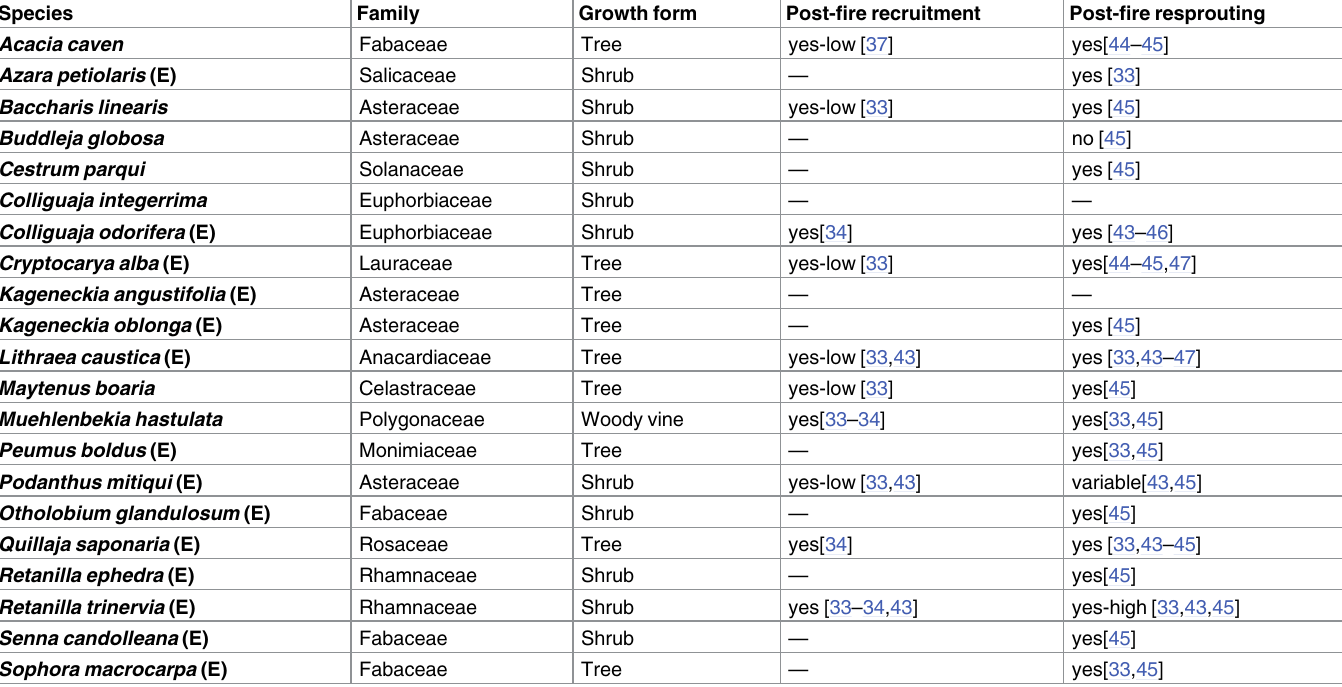
Table 1. List of studied species. Most of them are dominant species in the